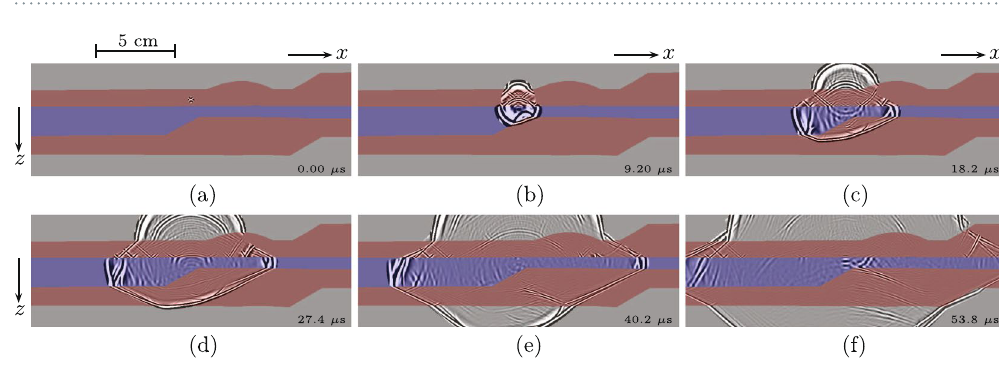
Figure 2. ( a ) 3D physical model. The grey-levels indicate different propagation velocities and mass densities. Ultrasonic reflection experiments are carried out along the diagonal line above the model. ( b ) 2D cross-section of the physical model (with modelled snapshots, for visualisation only) and the actually recorded response at the surface, G ( x ′ , x , t ) (here shown for 3 source positions x and 3 × 17 receiver positions x ′ ).